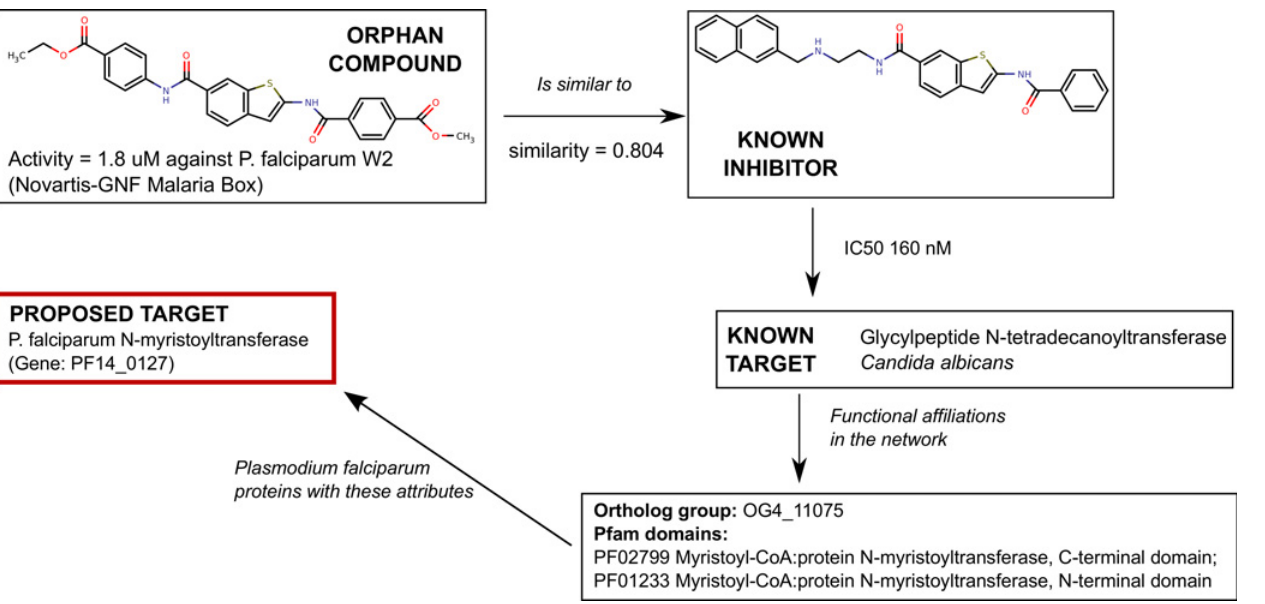
Fig 5. Suggesting targets for orphan compounds: example 1, N-myristoyltransferase. The compound shown in the upper panel (TDR Targets ID 606689, ChEMBL ID 688510) is an orphan compound (no known target) that was shown to be active against P. falciparum. A similar compound (Tanimoto similarity coefficient = 0.804), shown at the right, is active against a glycylpeptide N-tetradecanoyltransferase of Candida albicans [78] which belongs to the same ortholog group, and shares 2 Pfam domains with the P. falciparum N-myristoyltransferase (PlasmoDB ID